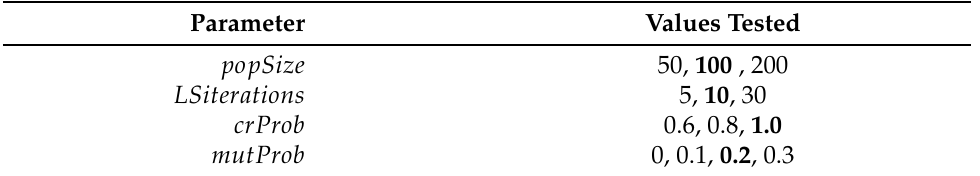
Table 3. Results of the parametric analysis for the evolutionary metaheuristic, showing the values tested and, in bold, the best configuration found.